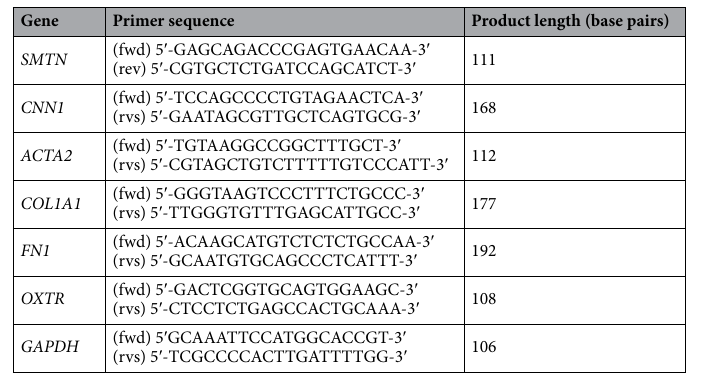
Table 2. PCR primer